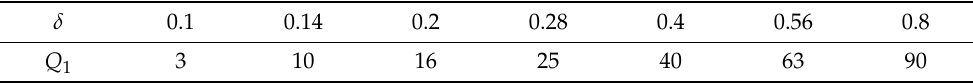
Table 1. Values of the parameters δ and Q 1 used in the initial conditions of the numerical simulations (every